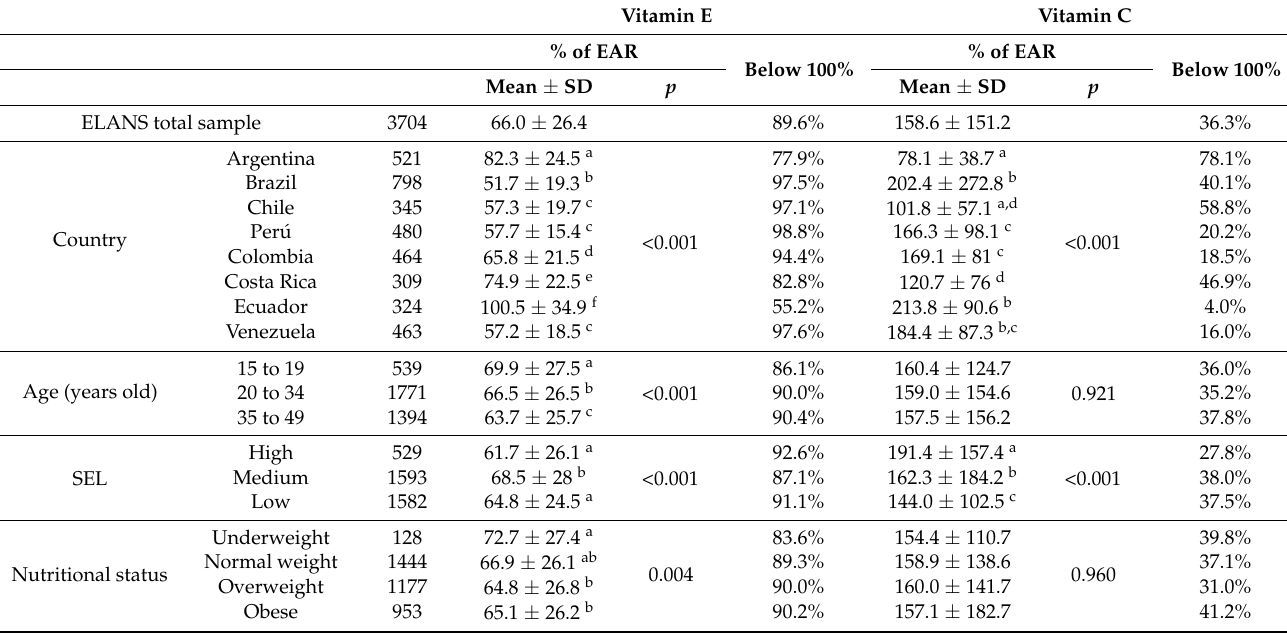
Table 3. Vitamin E and C intake (% of EAR and % below EAR) by country, age, SEL, and nutritional status. Vitamin